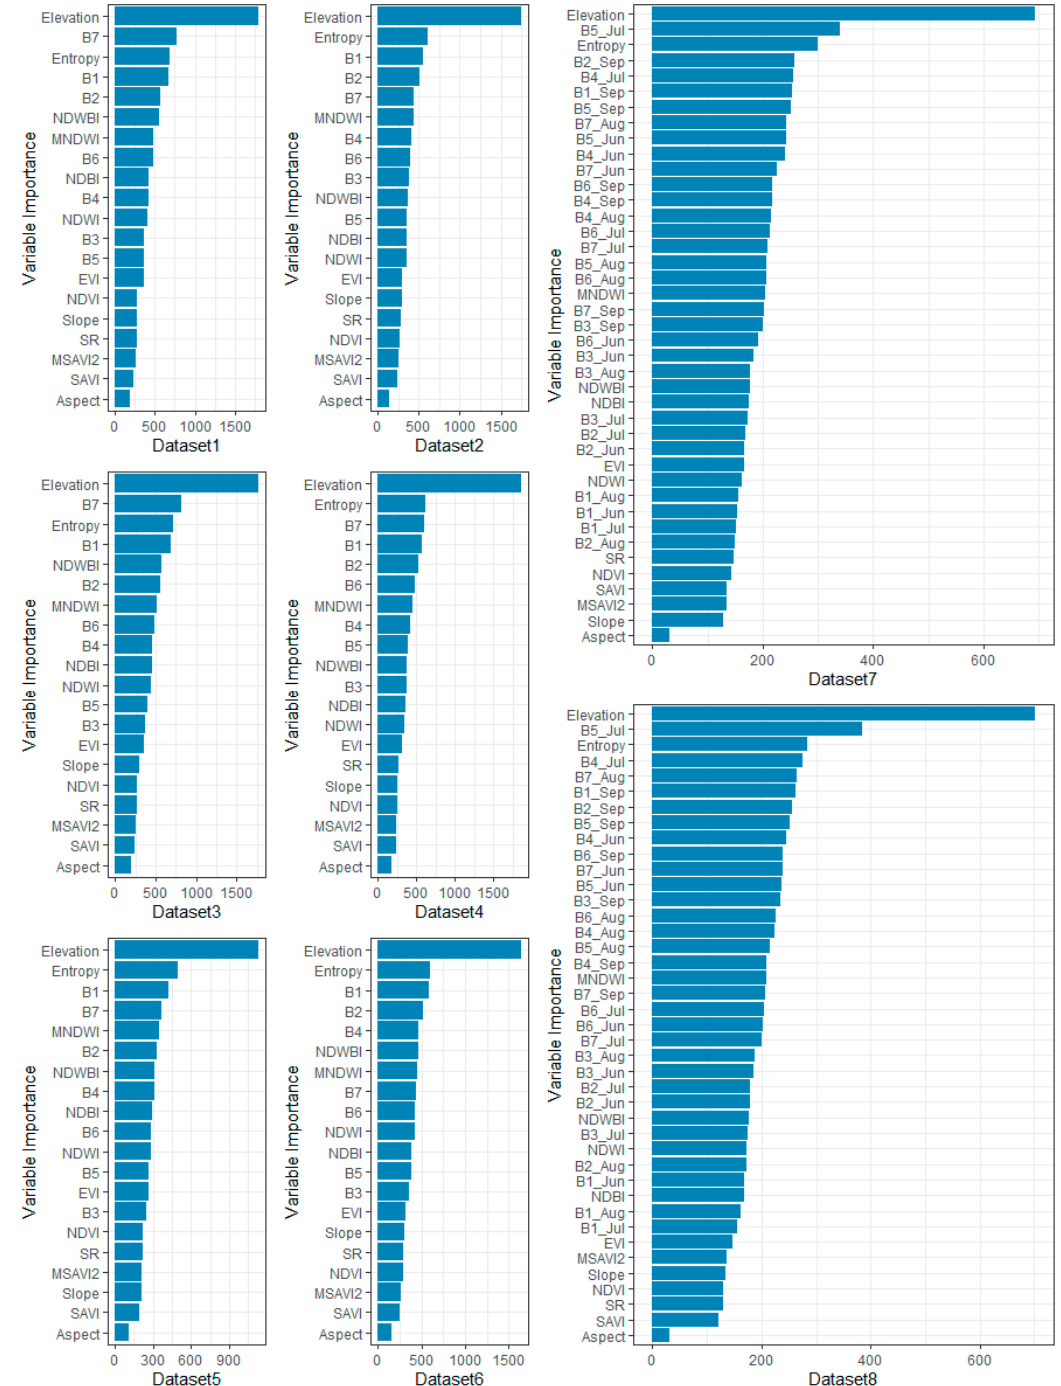
Figure 4. Variable importance in the Random Forest (RF) models trained on the eight datasets.